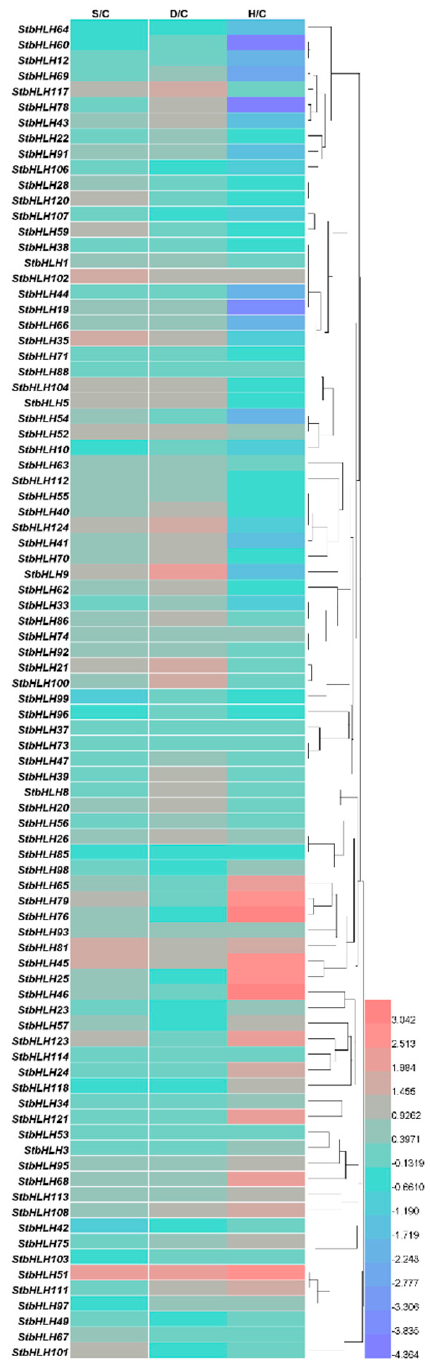
Figure 7. Expression heatmap of StbHLH genes under salt, drought and heat stress. FPKM values of StbHLH genes were transformed by log2, and the heatmap was constructed with HemI. The clustering tree was constructed by hierarchical clustering using average linkage method.